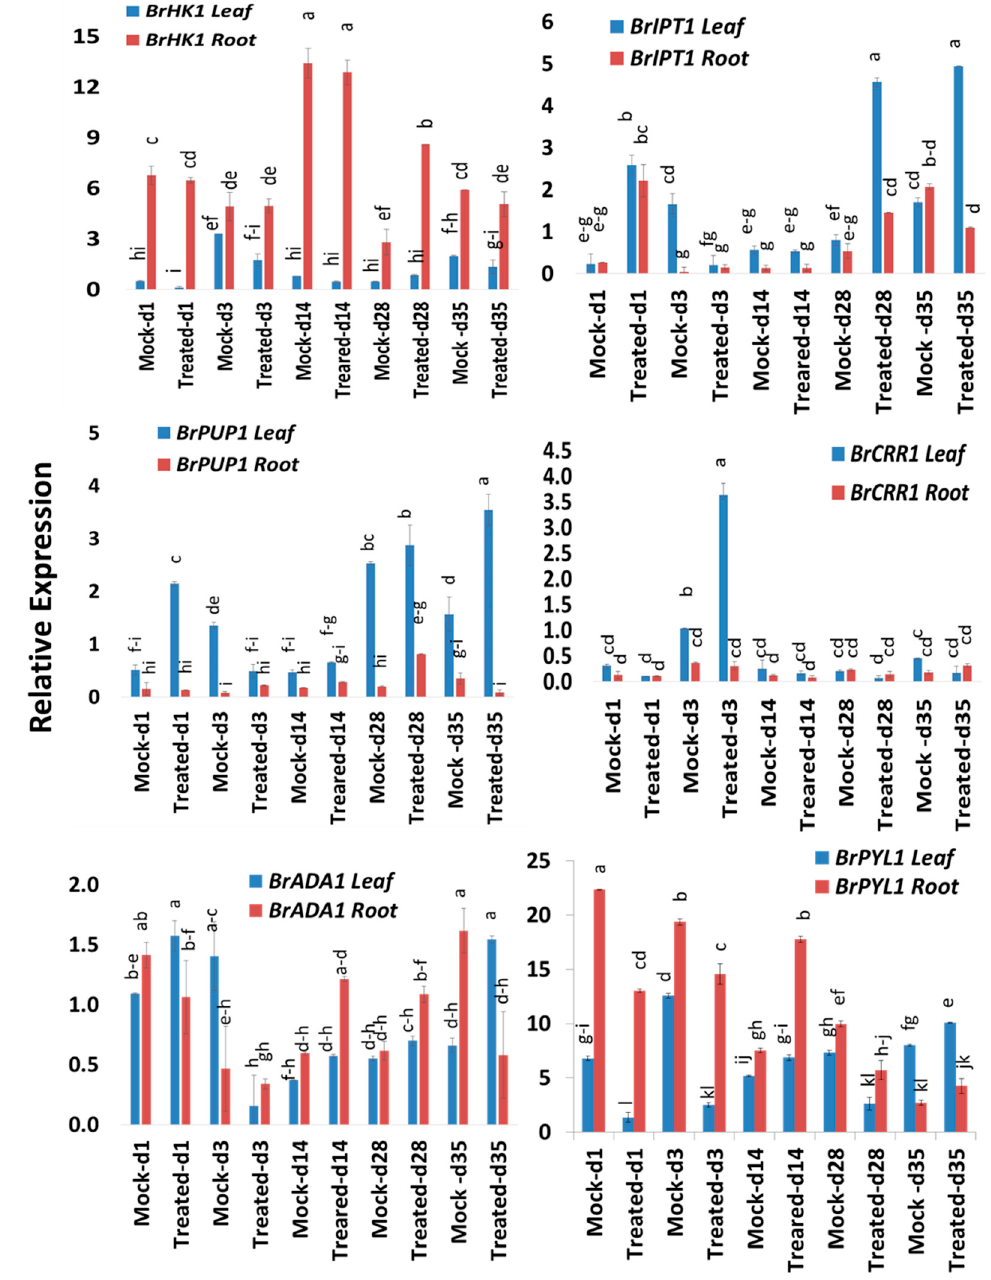
Figure 6. Variation in relative expression levels of cytokinin-related genes BrHK, BrCRR, BrPUP, BrADA, and BrIPT in leaf and root samples under di ff erent treatment × time-point combinations. Vertical bars compare relative expression levels among leaf vs. root, mock vs. treated samples at five time-points. Each data point represents the average of three samples. Vertical bars represent standard deviation. Values with di ff erent letters are significantly di ff erent at 5% level of significance according to Tukey’s pairwise comparisons. Gene expression levels in leaves from non-treated plants on Day 0 were set to 1.